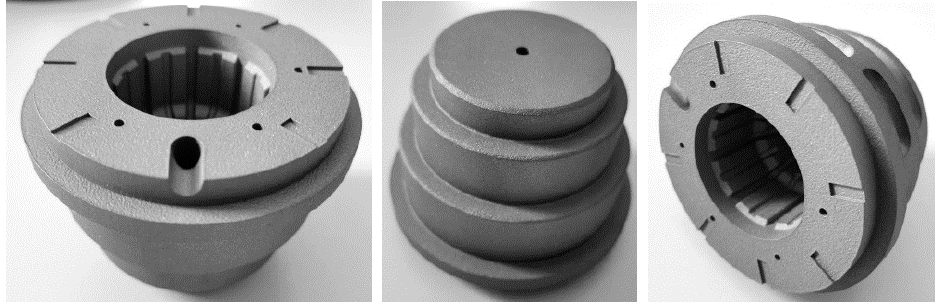
Figure 6. Fabricated mould insert with conformal cooling channels after SLM process including support removal.